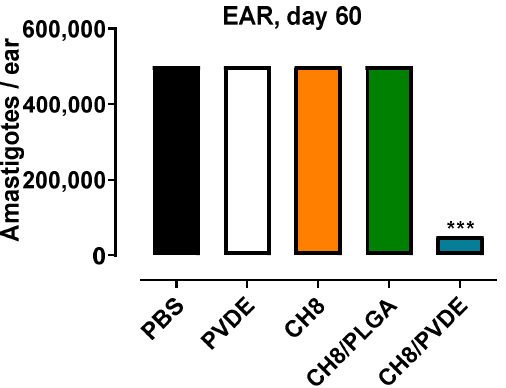
Figure 6. CH8/PVDE efficacy in L. braziliensis -infected hamsters. Golden hamsters were infected in the ear with 10 5 promastigotes of L. braziliensis . After 7 days, the animals received a single intralesional injection of CH8 (120 µ g/dose—1.3 mg/Kg body weight) encapsulated or not in the infected site. Controls received PBS alone or blank PVDE. On day 60 posttreatment, the parasite loads in the infected tissue were assayed by limiting dilution assay. Means ± SEM ( n = 10) *** p < 0001 vs. all groups.